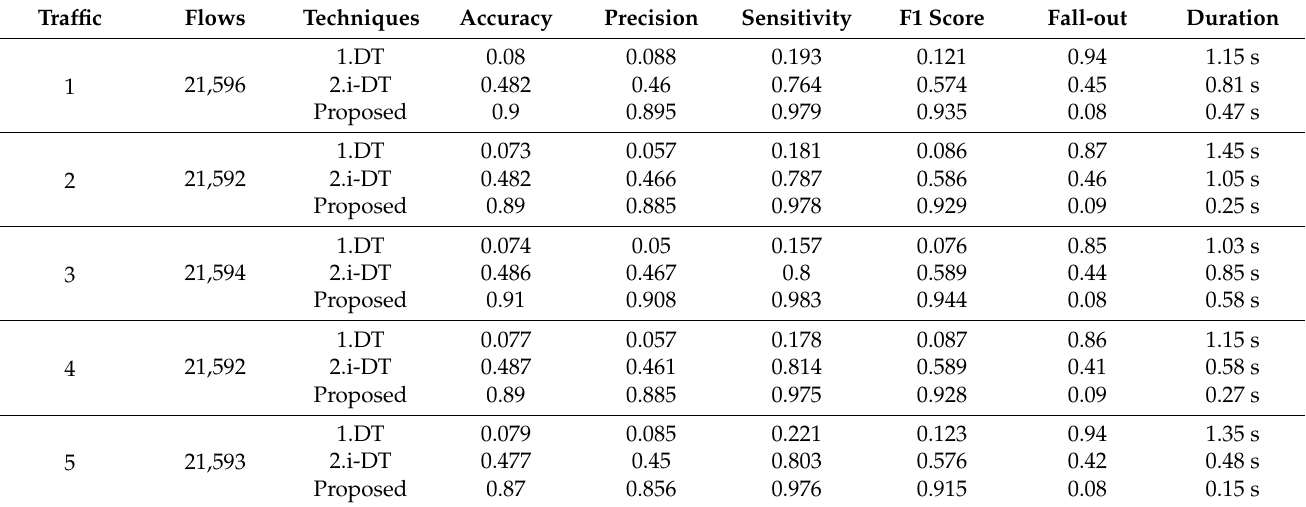
Table 14. Results of the traffic generation